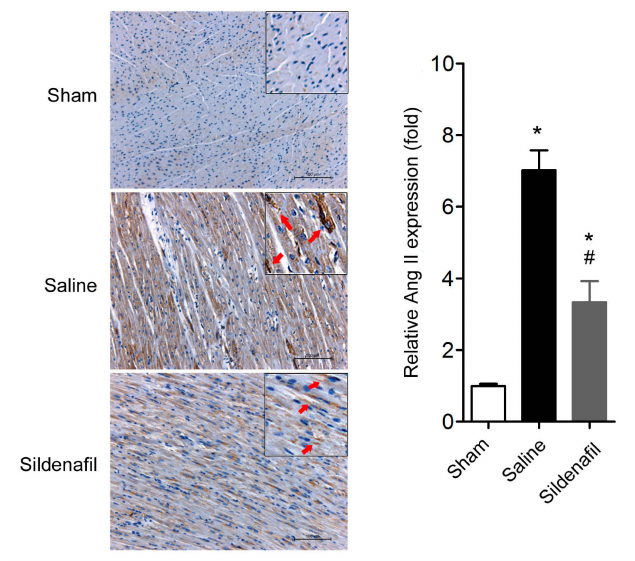
Figure 5. Myocardial Ang II expression was determined by immunohistochemistry. Representative image and quantitative analysis of Ang II immunohistochemical staining in myocardium. * p < 0.05 vs. Sham, # p < 0.05 vs. Saline. n = 6–10 per group. Scale bar: 100 um. The red arrows indicate the positive expression of Ang-II.